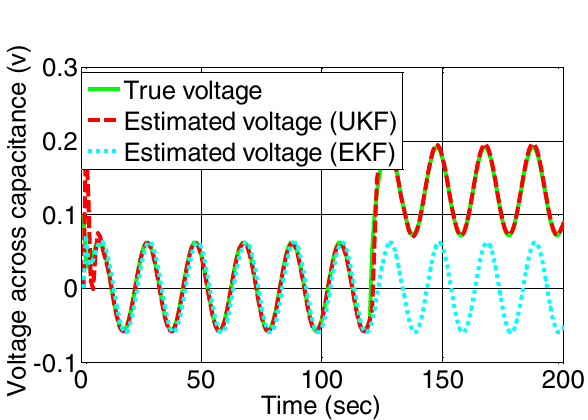
Figure 8. Error/residual evaluation for voltage across charge transfer capacitance estimation by EKF and UKF.